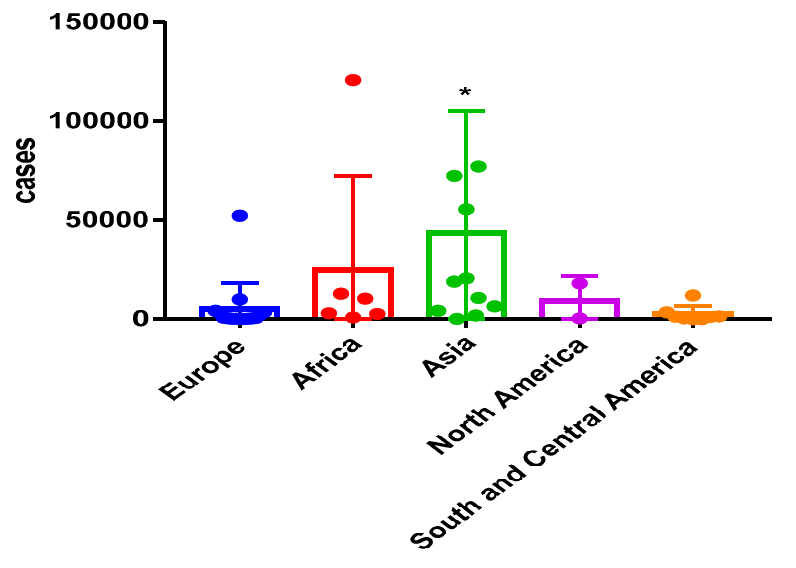
Figure 3. CPA prevalence across continents. * p < 0.05. Table 5. Country estimates of the burden of chronic pulmonary aspergillosis.